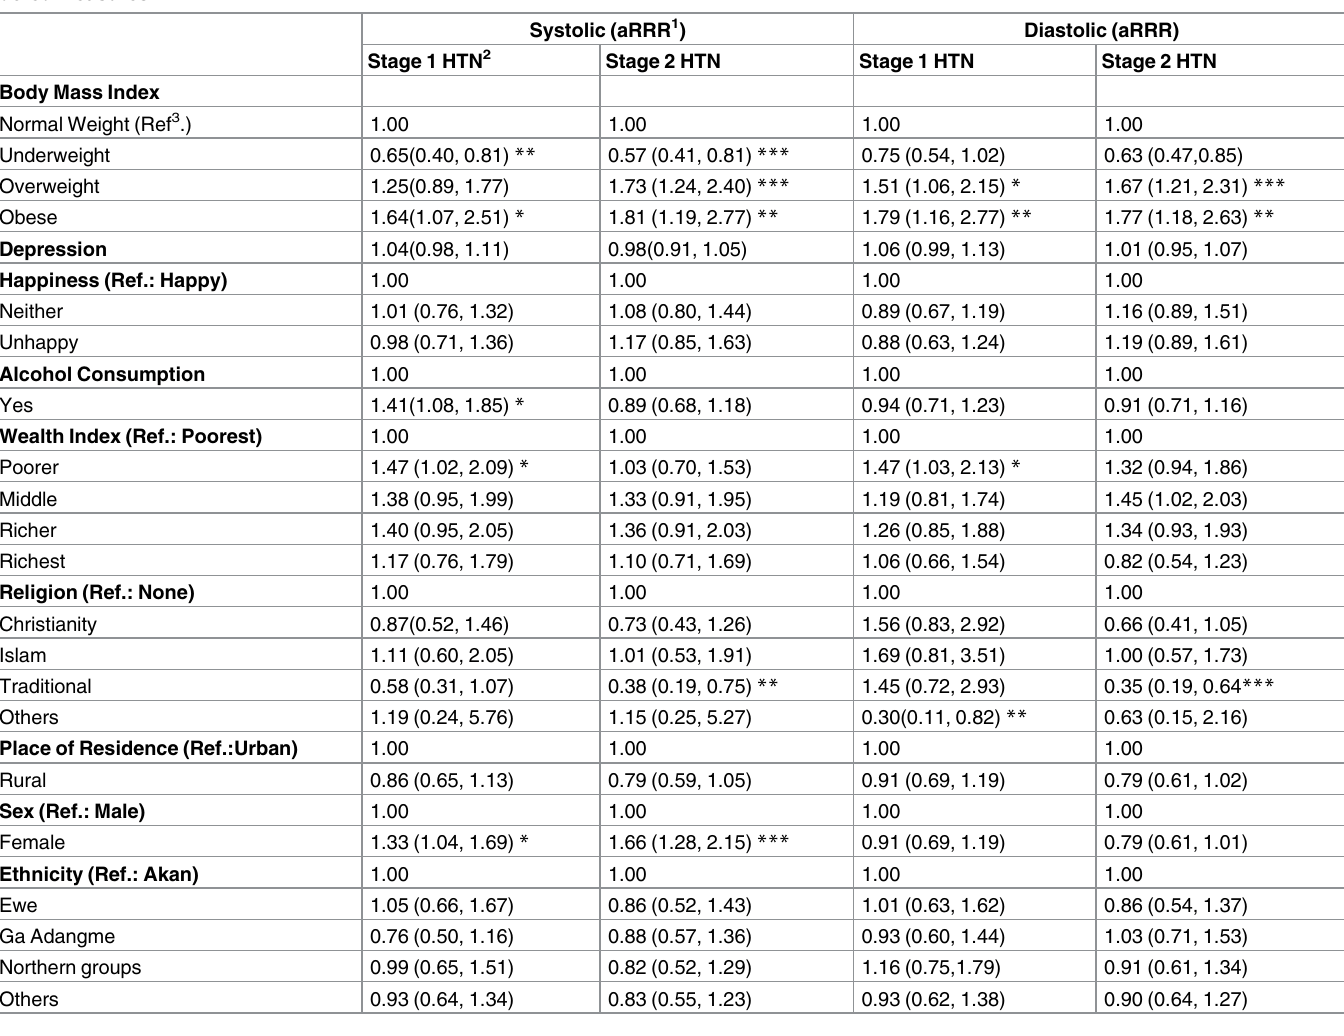
Table 2. Multilevel multinomial logit model of elderly obesity and its effect on stage 1 and stage 2 hypertension using systolic and diastolic unor- dered measures. Systolic (aRRR 1 ) Diastolic